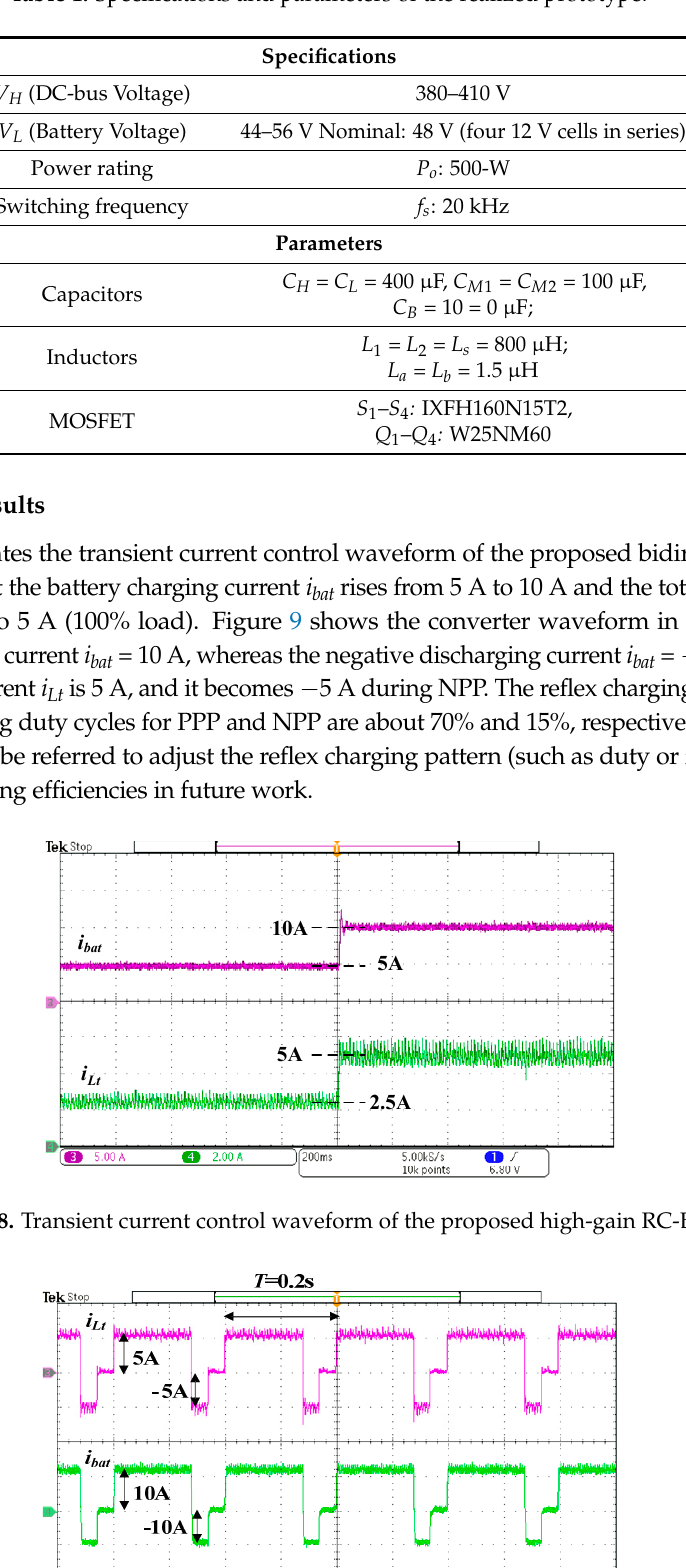
Table 1. Specifications and parameters of the realized prototype.